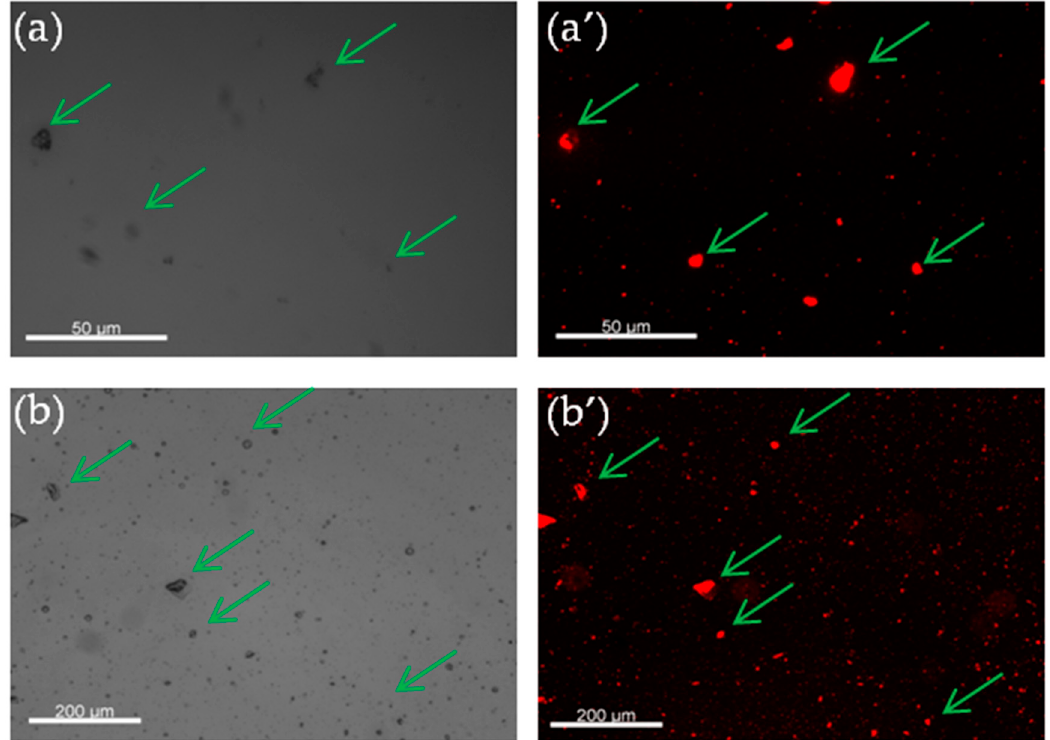
Figure 6. Fluorescence microscope images of fluorescent loaded nanoparticles. ( a ) Orange essential oil loaded nanoparticles with green light. ( a’ ) Orange essential oil loaded nanoparticles with white light. ( b ) Bergamot essential oil loaded nanoparticles with green light. ( b’ ) Bergamot essential oil loaded nanoparticles with white light.